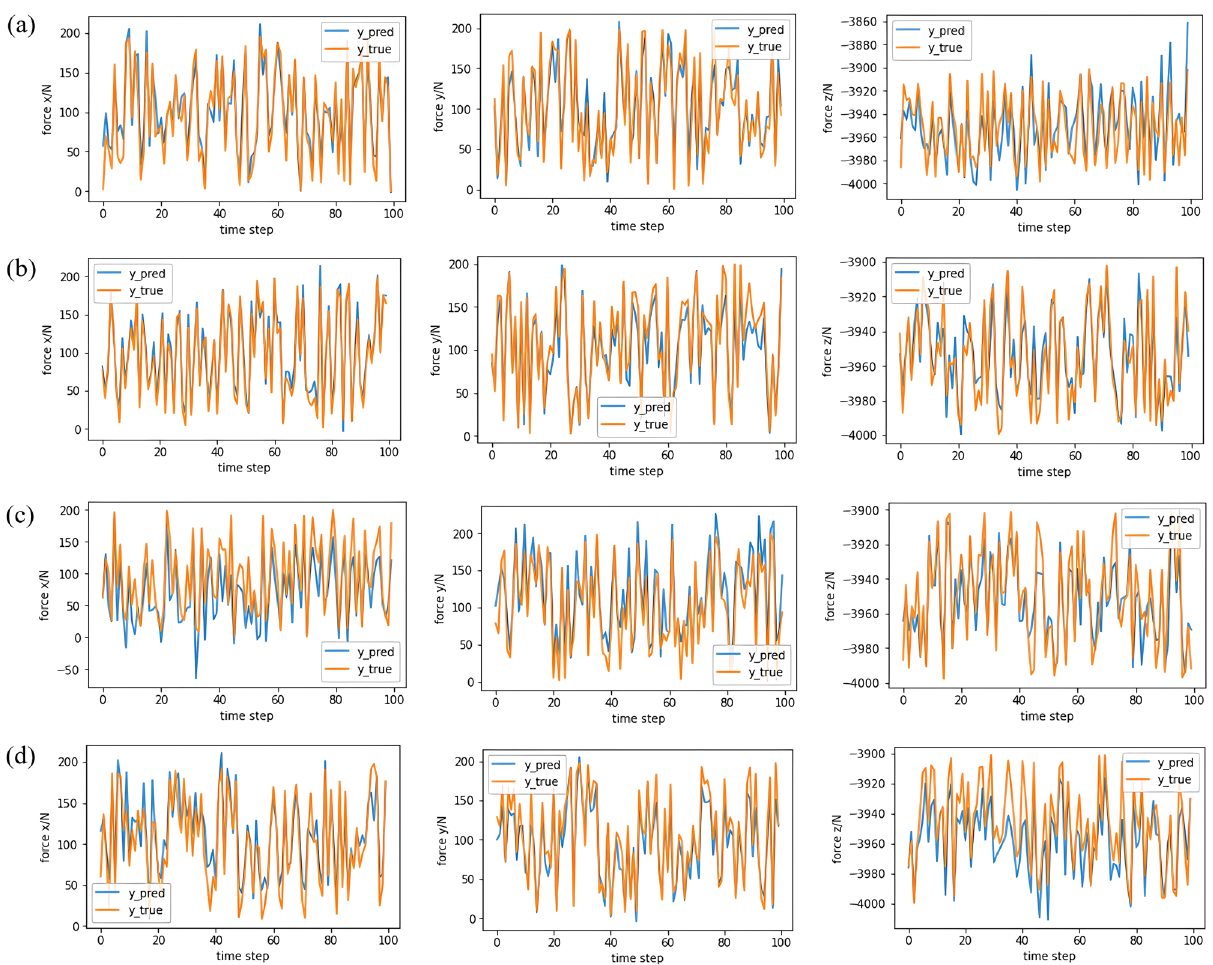
Figure 11. The prediction results of the proposed model under cutting parameters C1 ( a )–C4 ( d